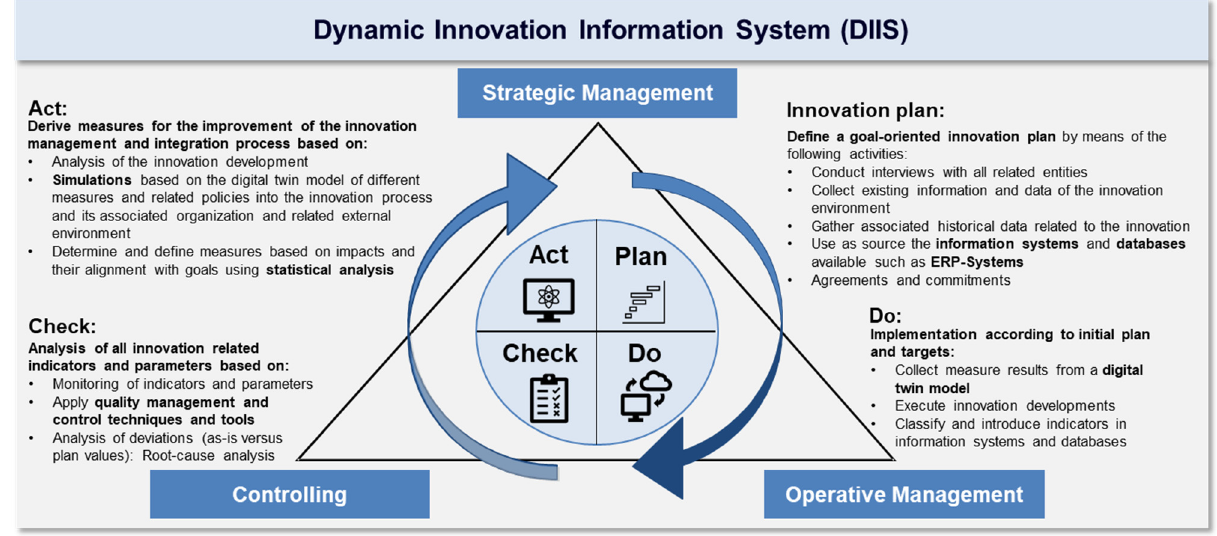
Figure 7. The Dynamic Information Innovation System (DIIS) (own elaboration).